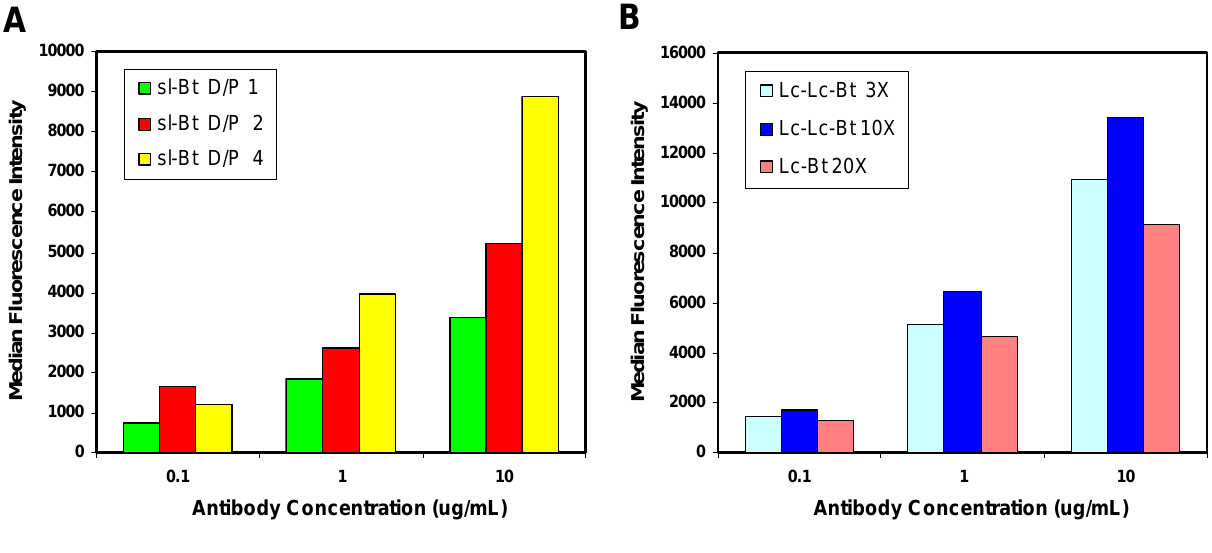
Figure 2 . Evaluating the role of biotinylation extent or linker length. Various biotinylated llama anti-ricin IgG were examined in a direct binding assay to ricin A chain-coated microspheres; Panel A shows signal with increasing number of biotins per antibody